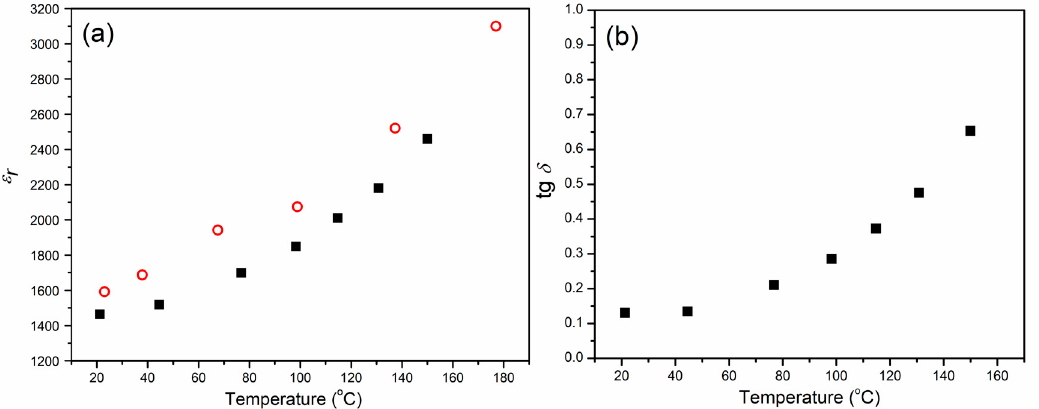
Figure 11. The temperature dependence of ( a ) relative dielectric constant was calculated based on impedance measurements (circle) and based on measured capacitance (square), and ( b ) dielectric loss for CCTO ceramic.